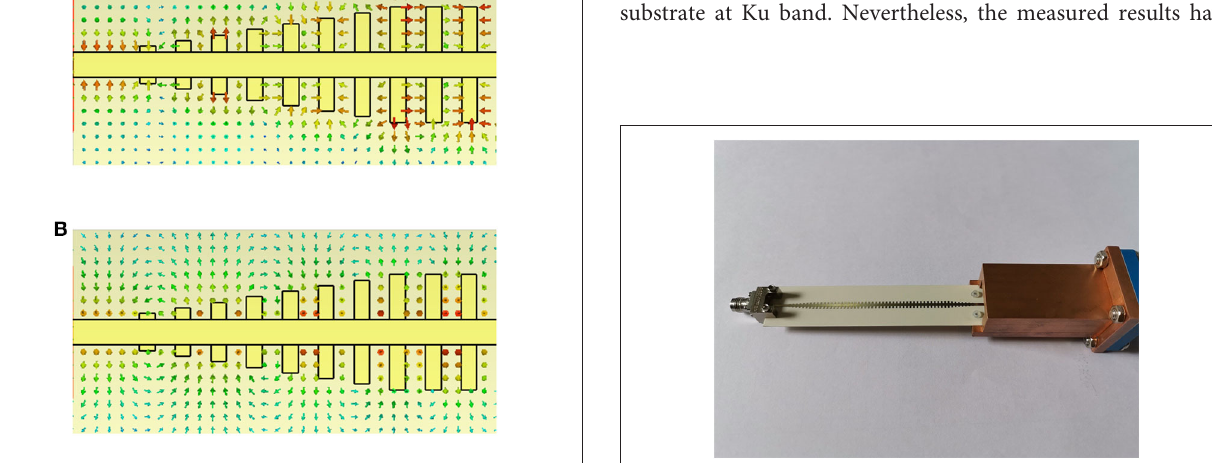
FIGURE 7 | Photo of the fabricated prototype.